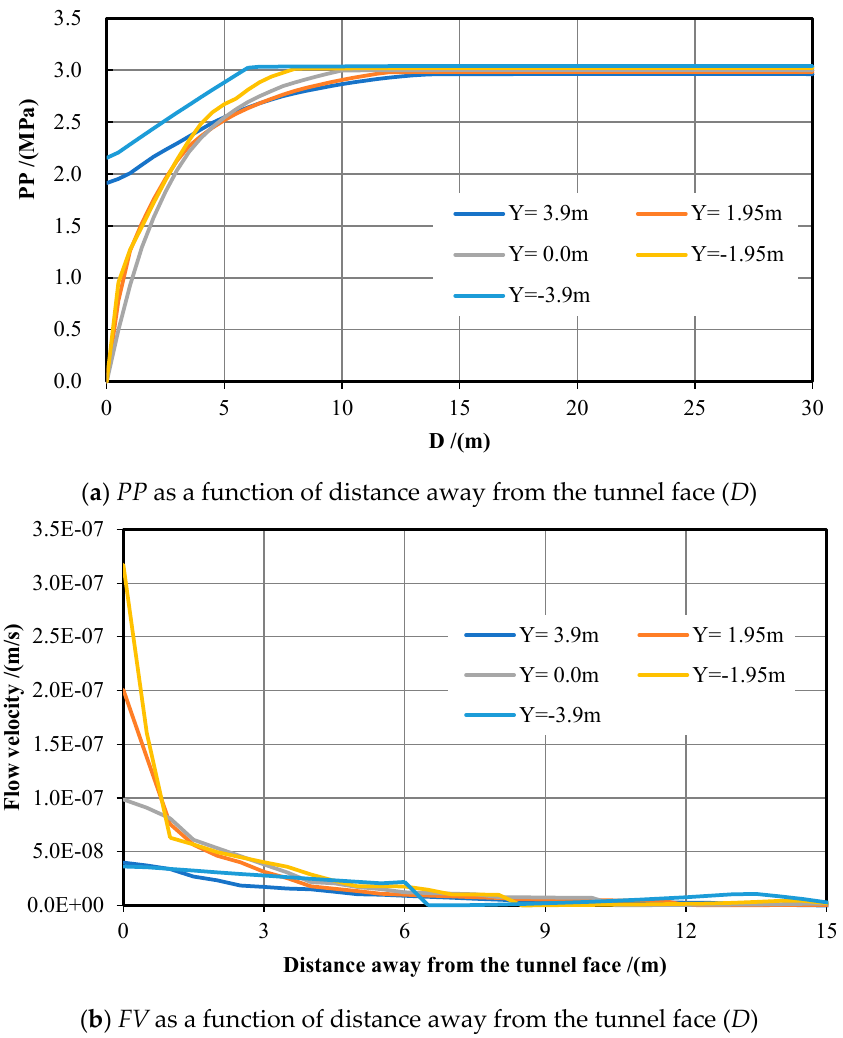
Figure 11. Pore pressure and flow velocity within 30 m ahead of the tunnel face as a function of distance away from the tunnel face (Y = − 40 m).